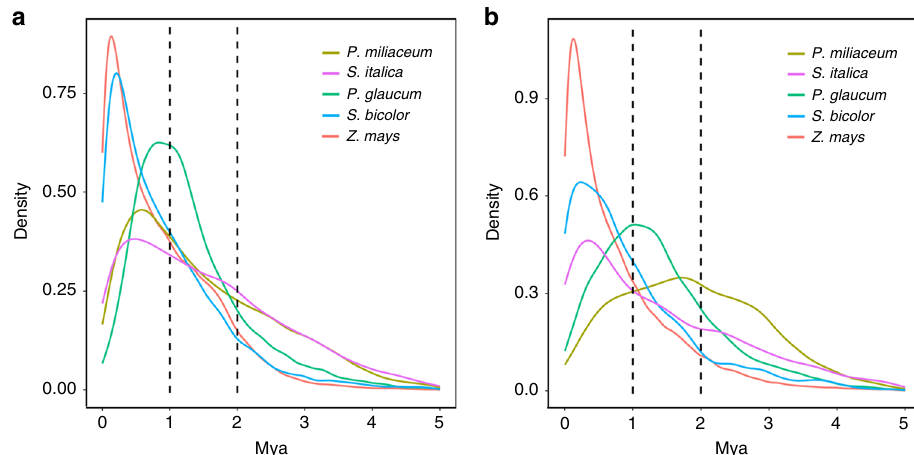
Fig. 3 The activity of LTR retrotransposons in Paniceae. The insertion time of Gypsy ( a ) and Copia ( b ) superfamilies were calculated in broomcorn millet ( P .